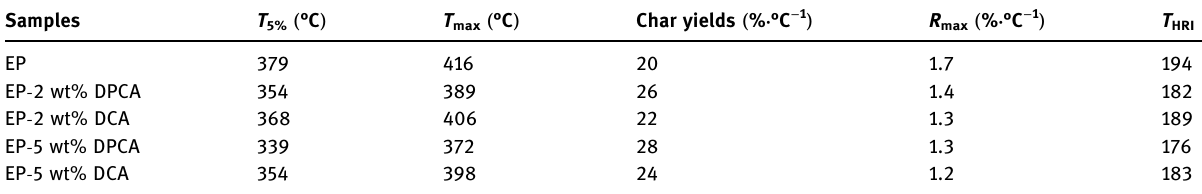
Table 2: TGA data of EP, EP - 2 wt% DPCA, EP - 2 wt% DCA, EP - 5 wt% DPCA, and EP - 5 wt% DCA in nitrogen Samples